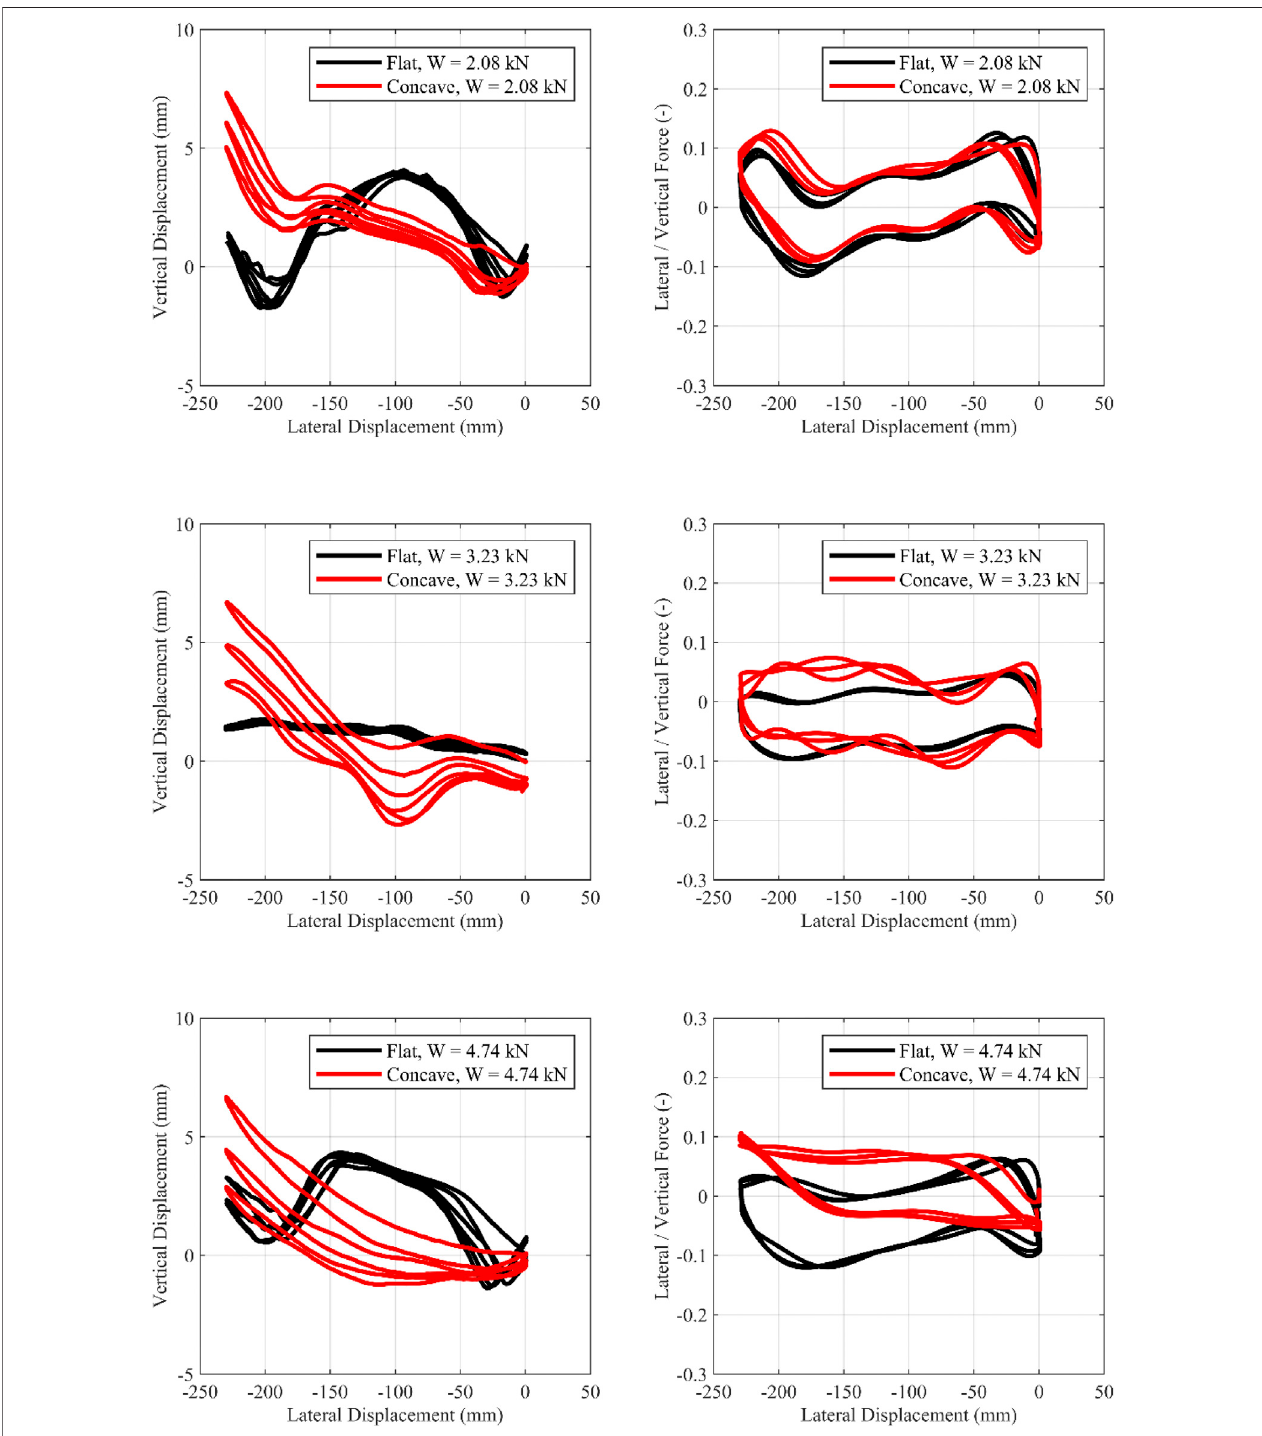
FIGURE 8 | Cyclic motion from 0/ − 230 mm. In fl uence of the geometry of the concrete plates. Left , Vertical-horizontal displacement; Right , Lateral/Vertical force — Lateral displacement.